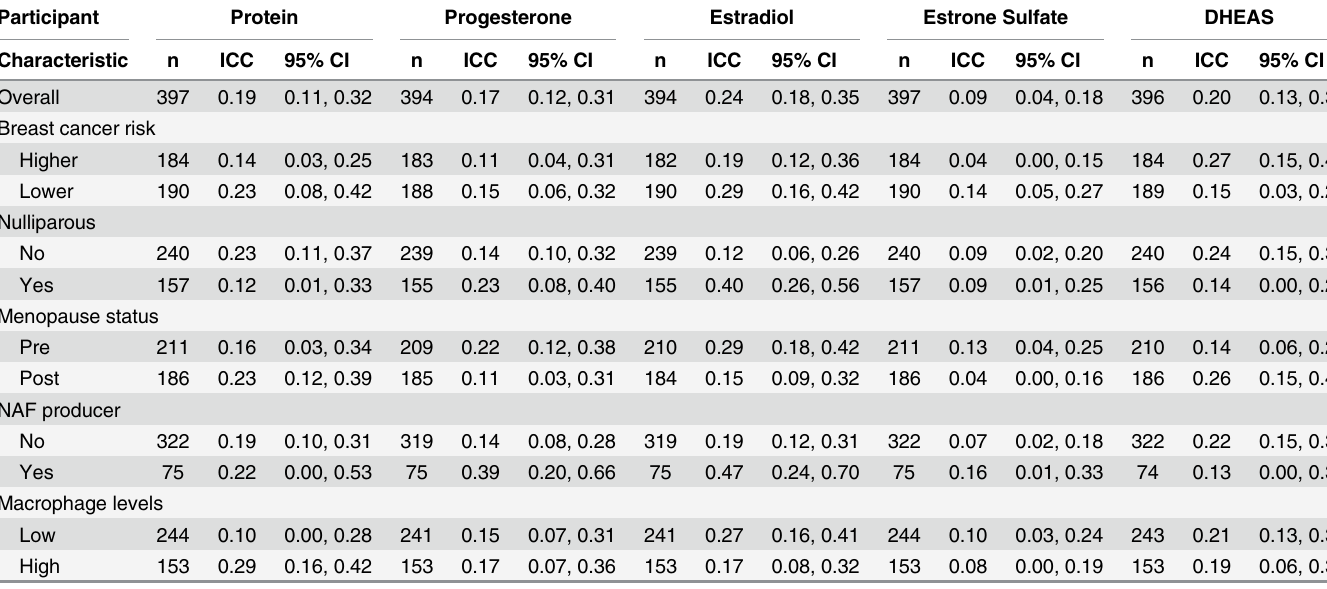
Table 4. Intraclass Correlation Coefficients (ICCs) and 95% Confidence Intervals (CIs) by Analyte and Participant Characteristics. 1